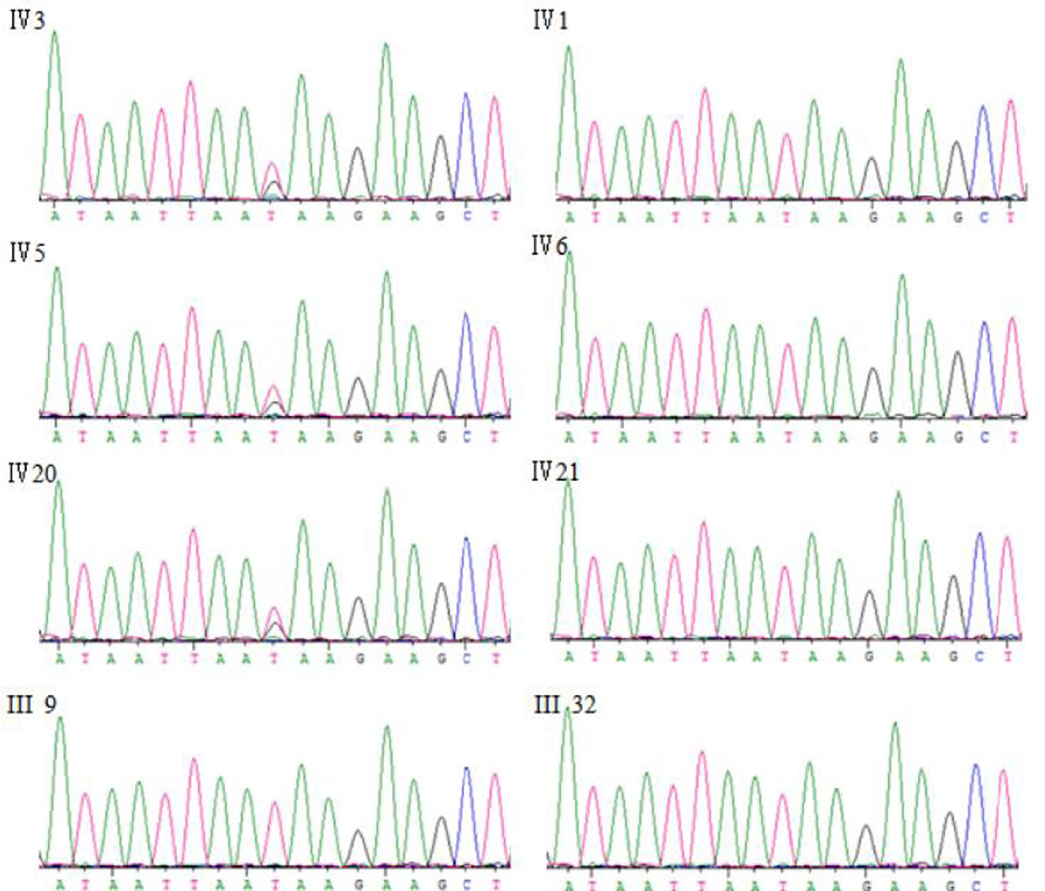
Fig 5. Sanger sequences of MAPT p.N279K mutation in this family. Ⅳ -3, Ⅳ -5, Ⅳ -20 are patients carrying the MAPT p.N279K mutation; IV-1, IV-6, IV-21, III-9, III-32 are unaffected family members.